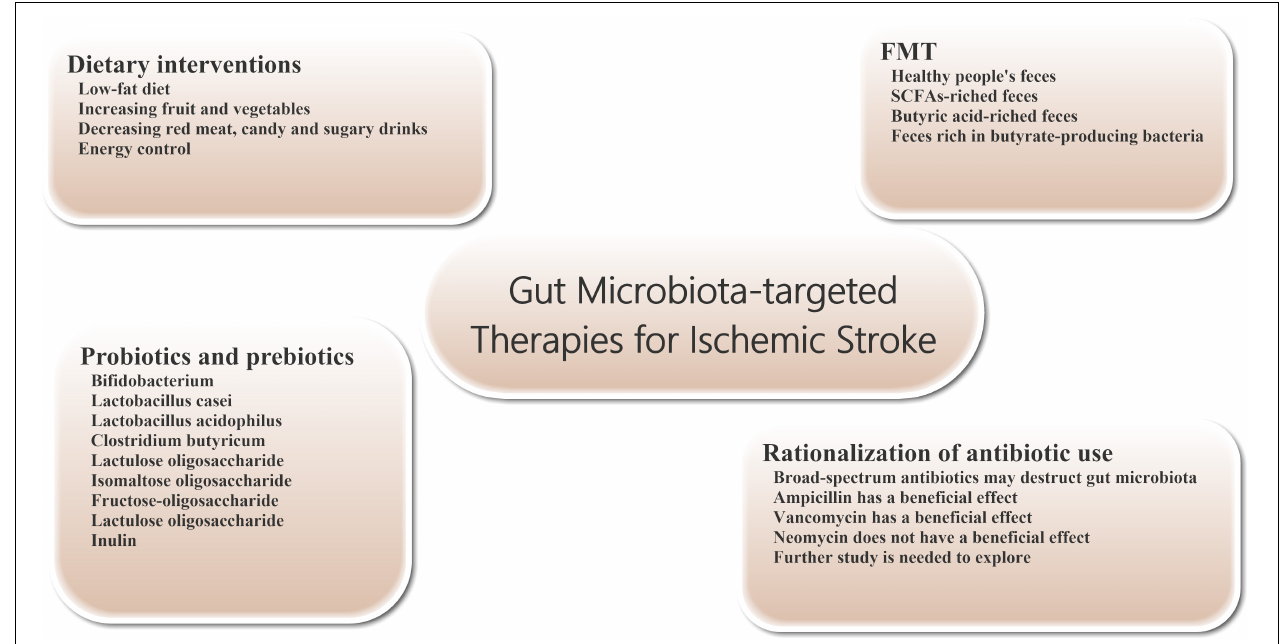
FIGURE 2 | Gut microbiota-targeted treatments and managements for ischemic stroke. Gut microbiota-targeted treatments and managements can be considered for patients with ischemic stroke, including dietary interventions, probiotics and prebiotics supplementation, FMT, and rationalization of antibiotic use. FMT, fecal microbiome